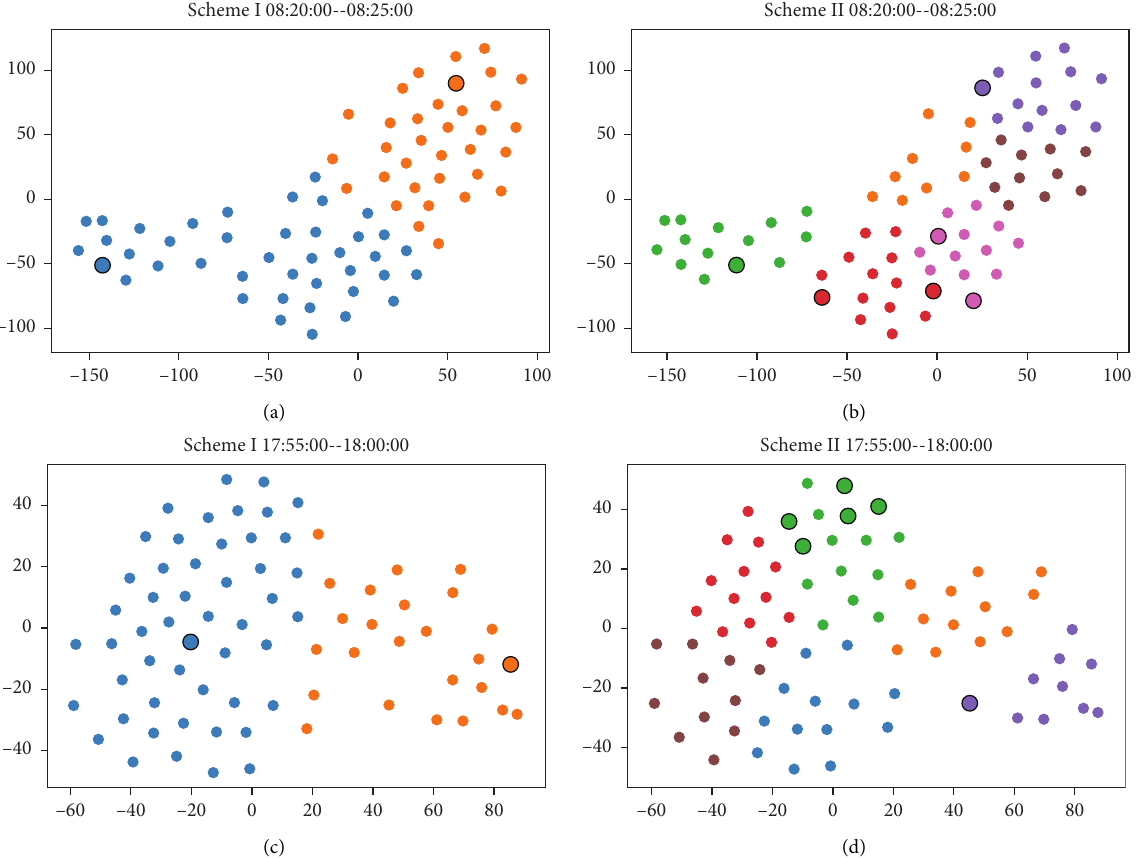
Figure 7: Feature visualization of schemes (critical segments are highlighted by a black